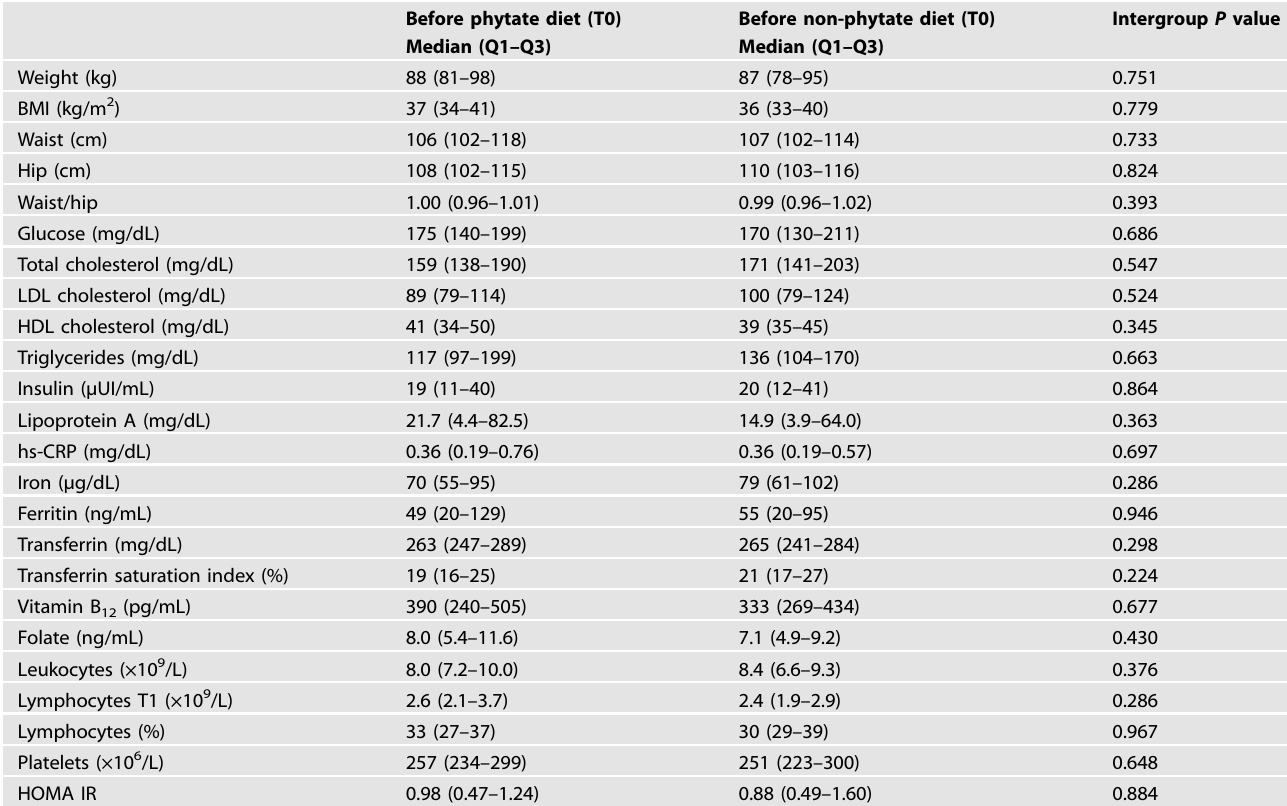
Table 2. Anthropometric and laboratory values before starting each diet.